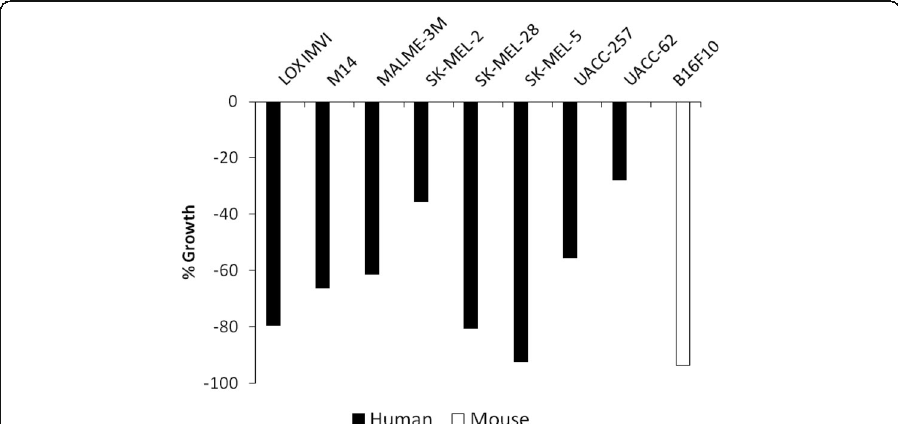
Fig. 1 Endoxifen activity in cultured cell lines. Cells were incubated with 10 μ M endoxifen for 48 h. Results are shown as a percentage of the cell growth measured for control cells. A 100% growth indicates a comparable growth rate with untreated control cells indicating no activity. A 0% growth indicates a complete growth arrest. A negative value indicates cell